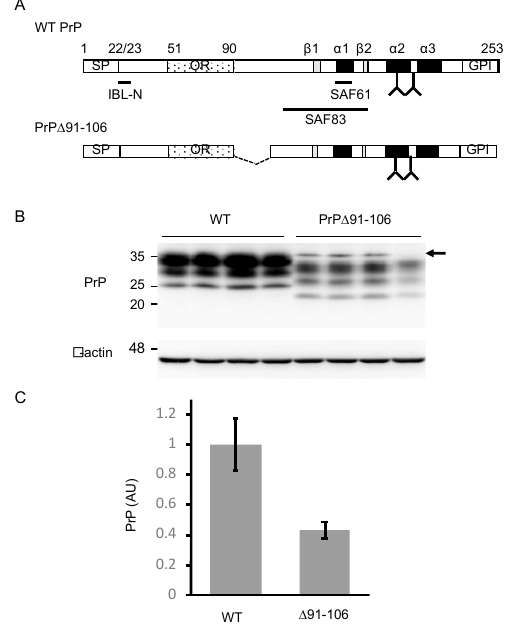
Figure 1. Generation of Tg(PrP ∆ 91–106) / Prnp 0 / 0 mice. ( A ) Schematic diagrams of wild-type (WT) PrP and PrP ∆ 91–106. The epitopes of IBL-N, SAF61 and SAF83 anti-PrP antibodies are shown. Arabic number, codon number; SP, signal peptide; OR, octapeptide repeat region; GPI, GPI anchor signal; α , α -helix; β , β -strand; Y, glycosylation site. ( B ) Western blotting (15% SDS-polyacrylamide gel (SDS-PAG)) of the brains (40 µ g of total proteins) of WT ( n = 4) and Tg(PrP ∆ 91–106) / Prnp 0 / 0 ( n = 4) mice with IBL-N anti-PrP antibodies. An arrow indicates non-specific signals. β -actin was used as an internal control (15 µ g of total proteins, 15% SDS-PAG). ( C ) Densitometric analysis of WT PrP C and PrP ∆ 91–106 in the brains of WT and Tg(PrP ∆ 91–106) / Prnp 0 / 0 mice in ( B ) after normalization against β -actin. AU, arbitrary units. Data are represented as the mean ± standard deviation